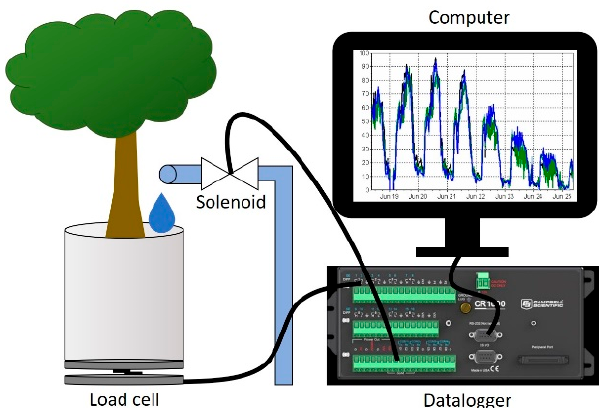
Figure 2. Diagram of individual lysimeter cell consisting of a 35 kg weighing load cell enclosed by two aluminum plates and connected to a data logger. Data loggers also controlled irrigation through solenoid valves and drip tubes connected to each bucket. Rootstocks had water withheld until transpiration rates declined by 75% during Trial 1, and 70% in Trial 2. Once transpiration rates declined to these thresholds irrigation was independently triggered for each individual tree, returning the soil to field capacity.